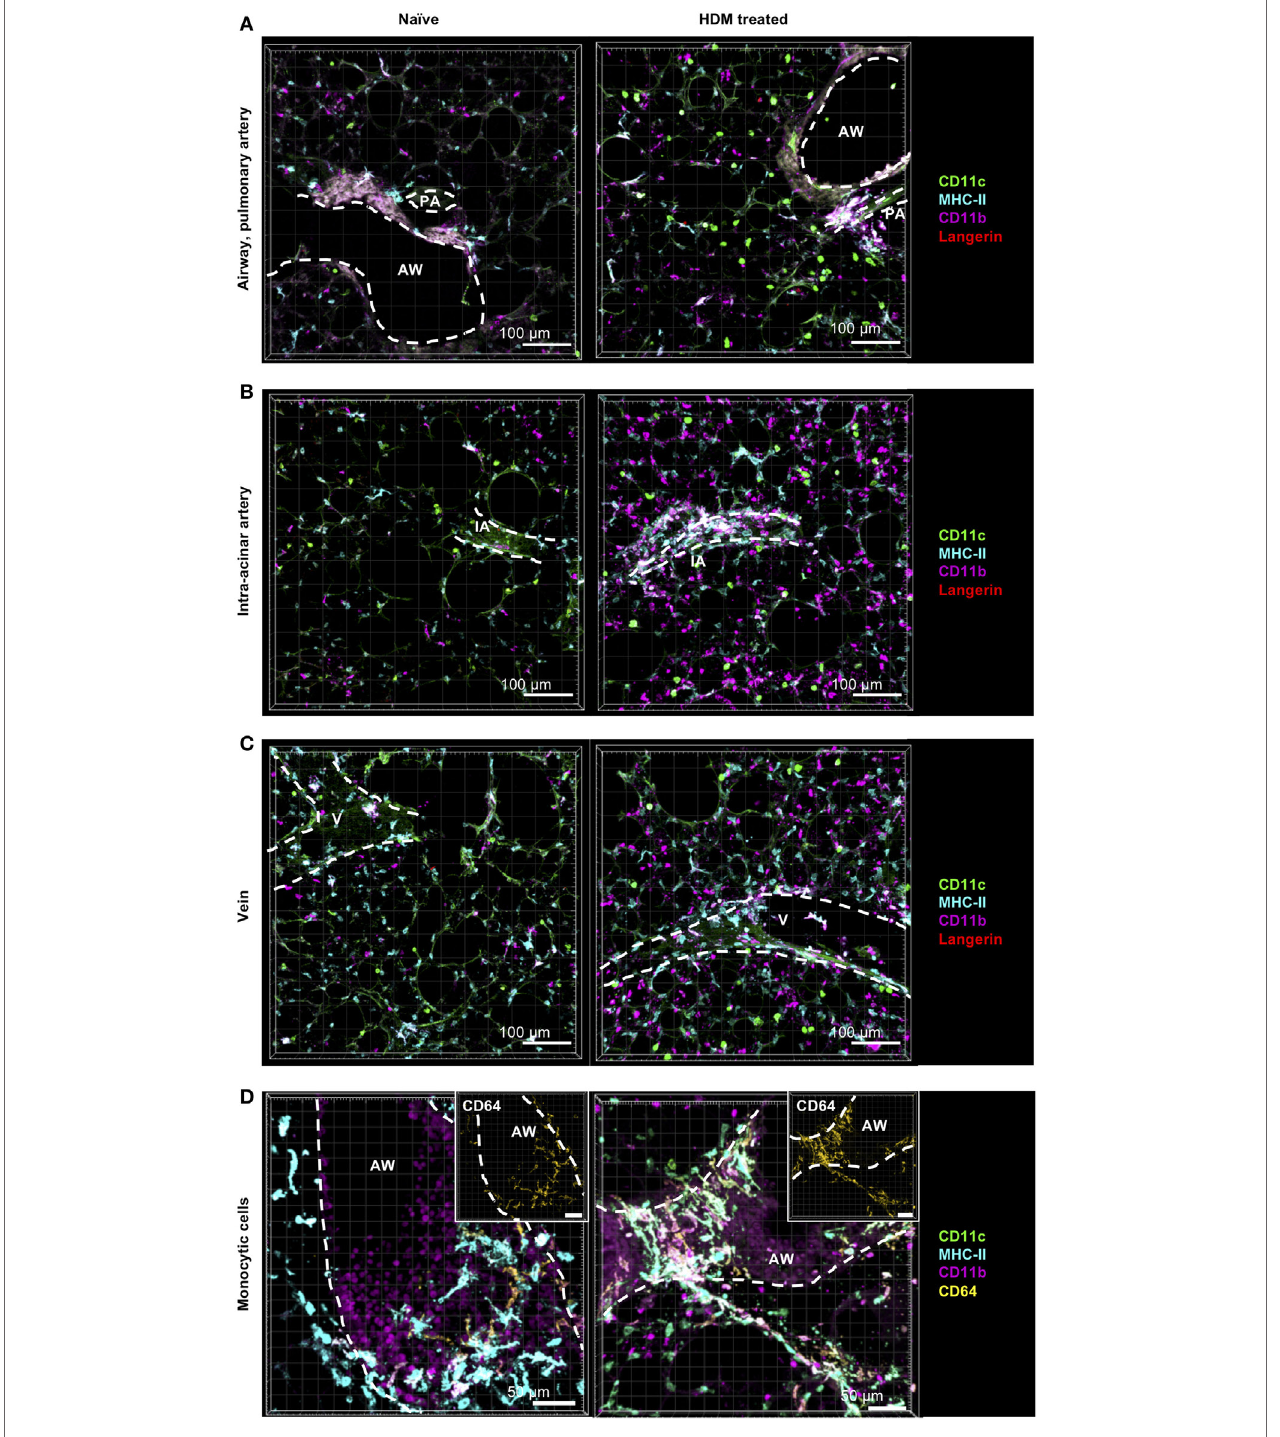
FigUre 7 | Allergic sensitization induces cellular accumulation of CD11b + monocyte-derived dendritic cells (moDCs) around AWs and blood vessels. C57BL/6 mice were anesthetized and immunized intratracheally with house dust mite extract (HDM) (100 µg). A total of 24 h after immunization mice were sacrificed, precision cut lung slices (PCLS) (300 µm) were generated and stained with anti-CD11c (green), anti-MHC-II (turquois), anti-CD11b (purple), and anti-Langerin (red) or anti-CD64 (yellow) ABs (right panel). Naive C57/BL6 mice served as controls (left panel). Stained slices were evaluated with confocal microscopy. Localization of conventional DCs (cDCs), interstitial macrophages (IMs), and alveolar macrophages (AMs) was determined in the interstitium around AWs and pulmonary arteries (a) , around IAs (B) , Vs (c) and in the alveolar lumen (a–c) . Accumulation of CD64 + CD11b + DCs was determined around AWs (D) . Dashed lines indicate AWs and/or vessels. Abbreviations: AW, airway; V, vein; IA, intra-acinar artery. Data are representative of at least three independent